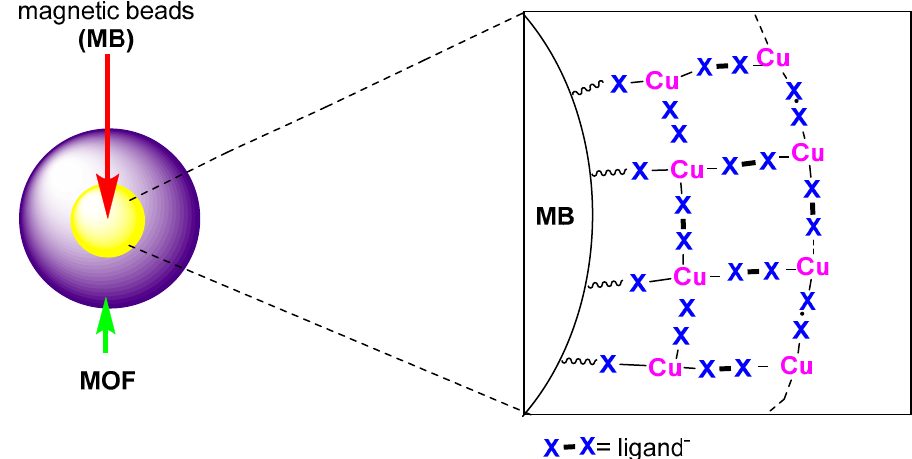
Figure 3. MOF-encapsulated MB catalyst.